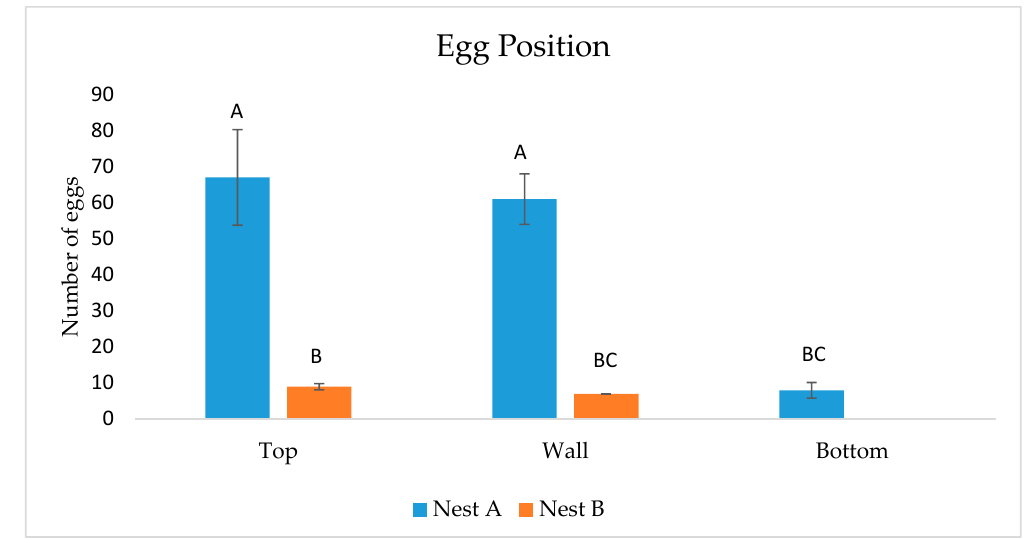
Figure 2. Number of C. iphitalis eggs found on various cage surfaces after 21 h. Different letters above bars represent significant differences.